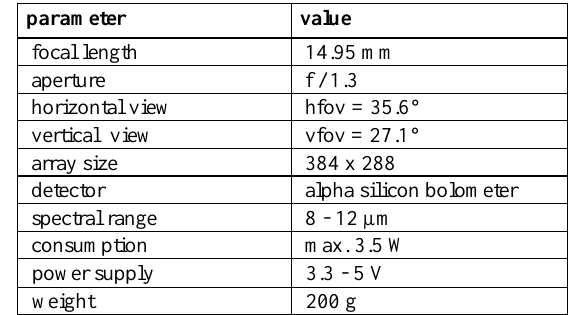
Table 3: Technical Facts of Miricle KS 110